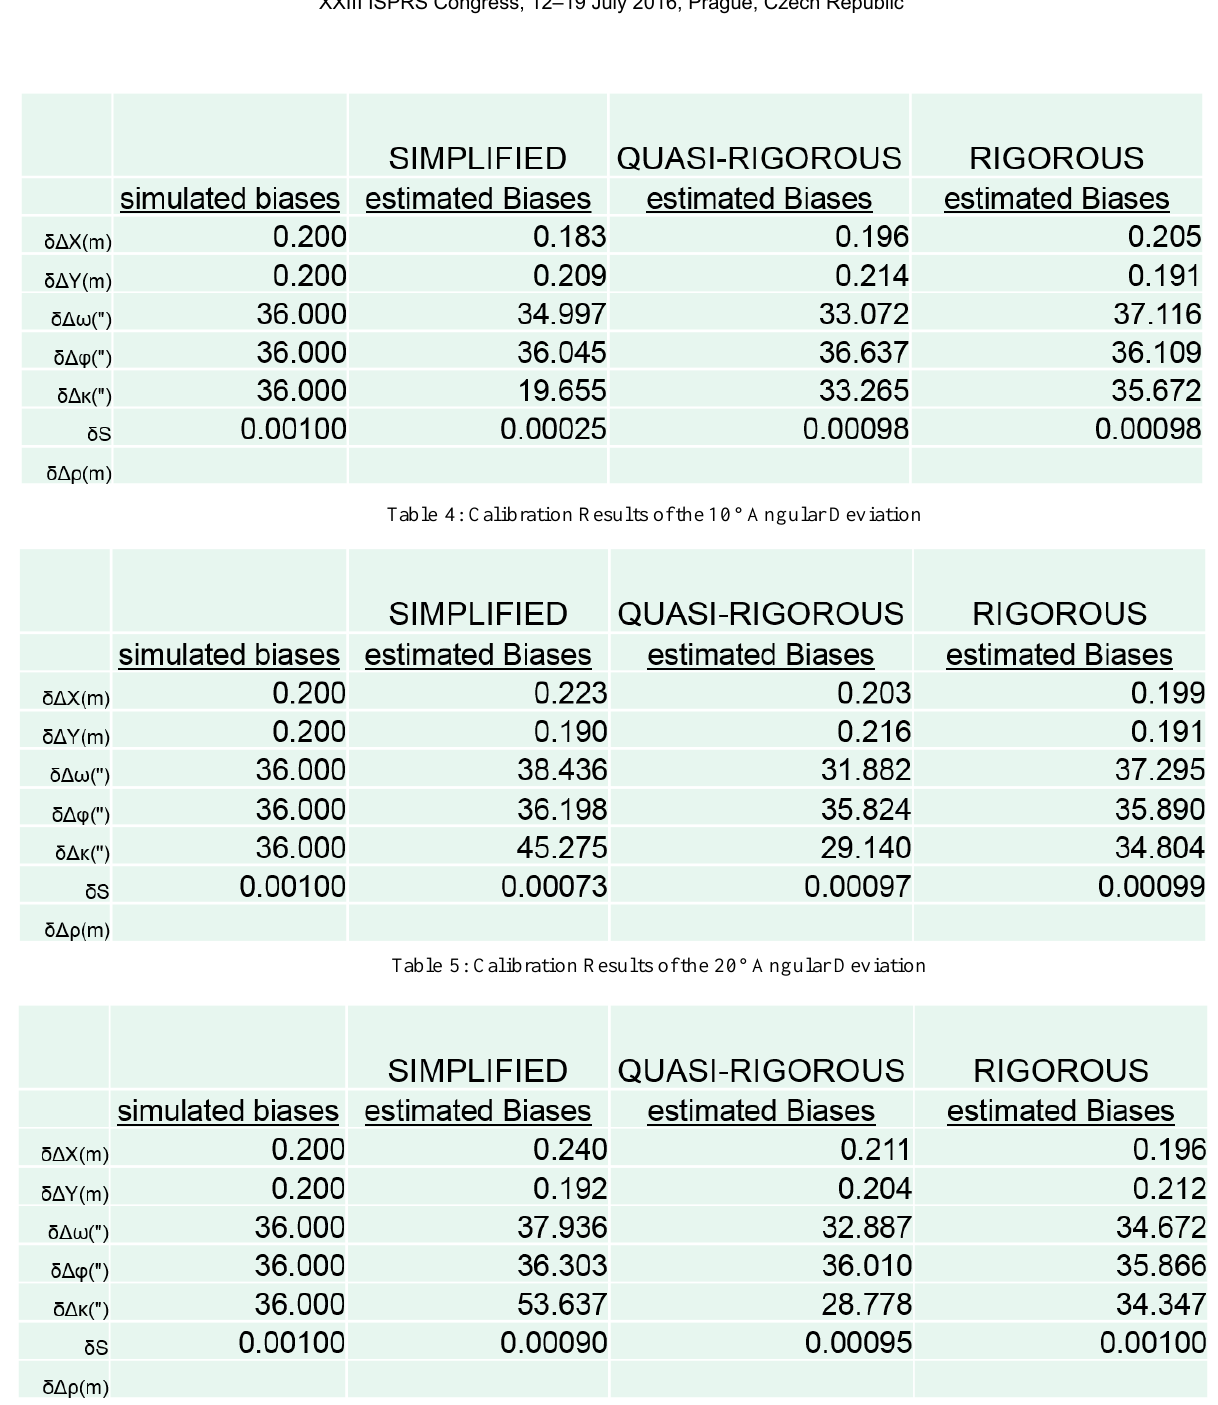
Table 6: Calibration Results of the 30° Angular